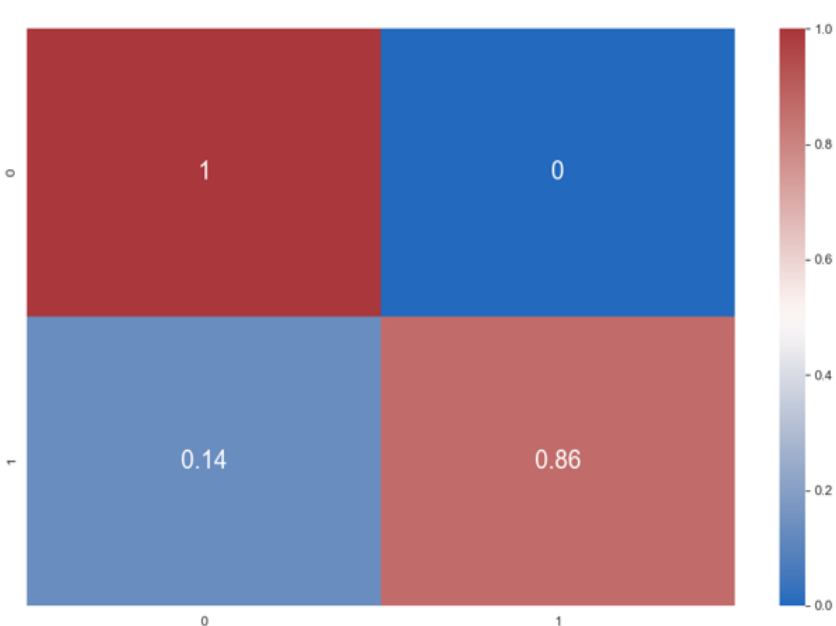
Figure 5. Eagles Feature Selection-based tuning applied to a confusion matrix for tuning.